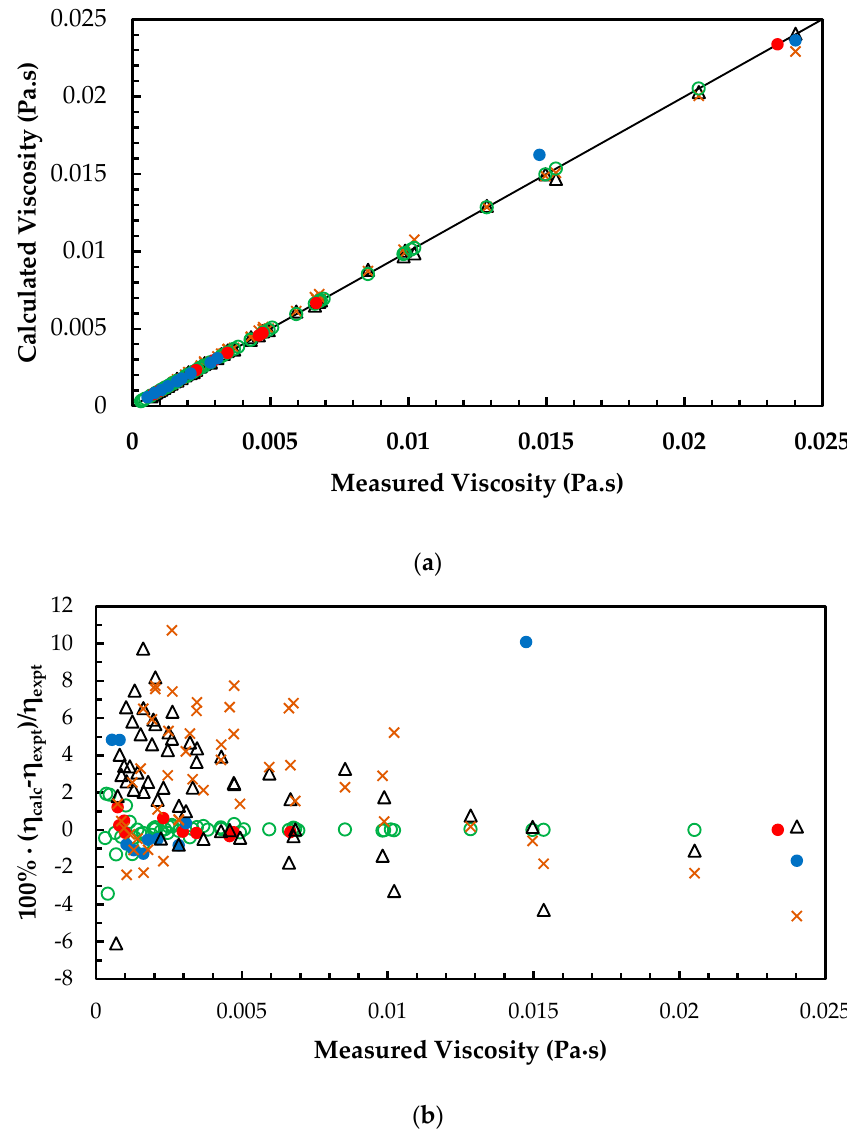
Figure 4. ( a ) Comparison of correlated viscosity with measured viscosity for MEA + H 2 O mixtures. ANN: Training data, ‘ ○ ’; Validation data, ‘ ● ’; Test data, ‘ ● ’. Arachchige et al. [25], ‘ x ’. Hartono et al. [11], ‘ ∆ ’. ( b ) Percentage deviation of correlated viscosity from measured viscosity for MEA + H 2 O mixtures. ANN: Training data, ‘ ○ ’; Validation data, ‘ ● ’; Test data, ‘ ● ’. Arachchige et al. [25], ‘ x ’. Hartono et al. [11], ‘ ∆ ’.